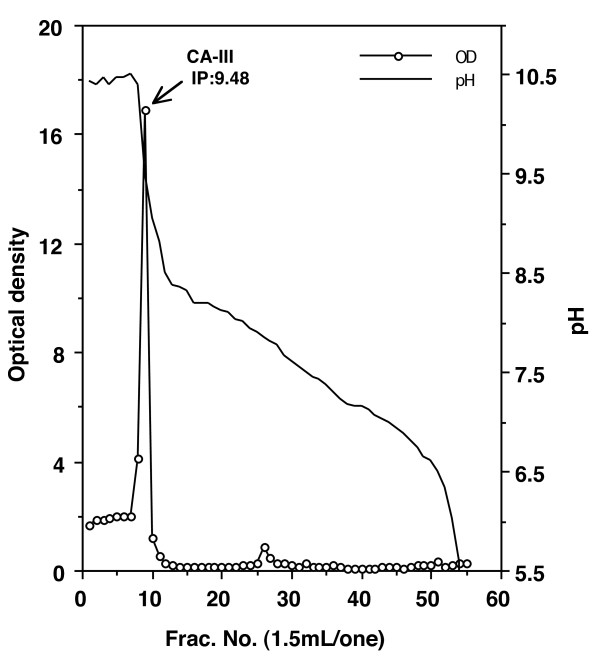
Results of column electrofocusing of the fractions that constituted the Fr-A peak in Figure 2. The main peak (IP: 9.48) contain chicken CA-III. Values were obtained by using a spectroscope at 280 nm. OD = optical density. Ampholine: pH 8.0-10.5.